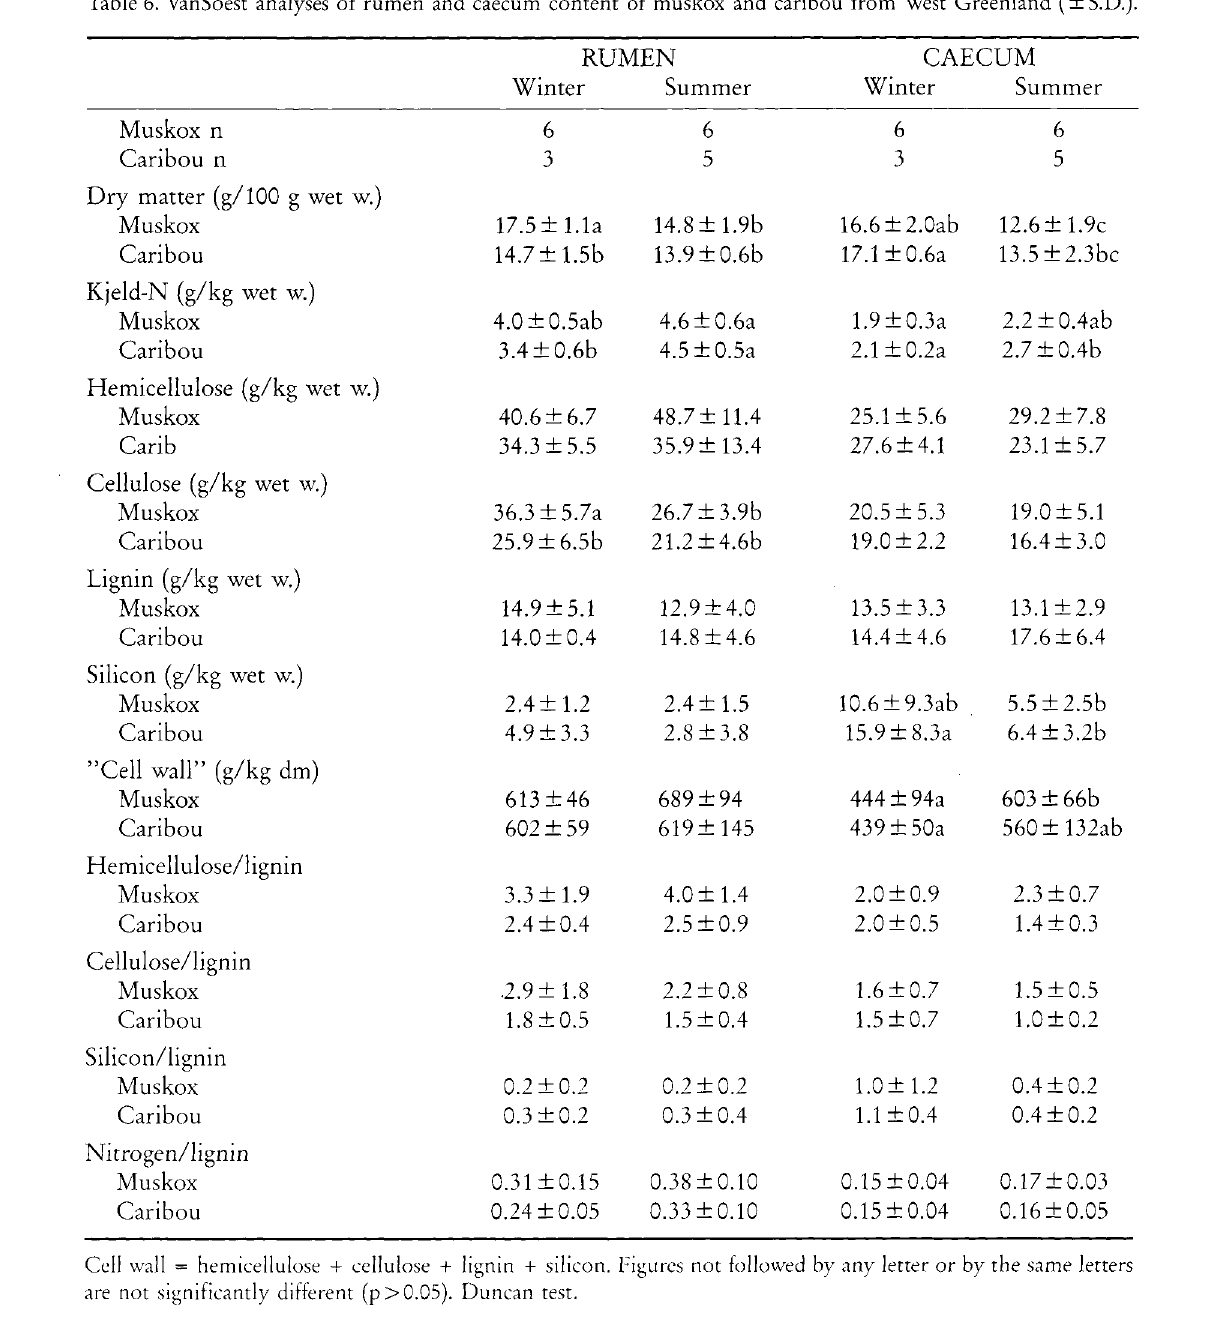
Table 6. VanSoest analyses of rumen and caecum content of muskox and caribou from West Greenland